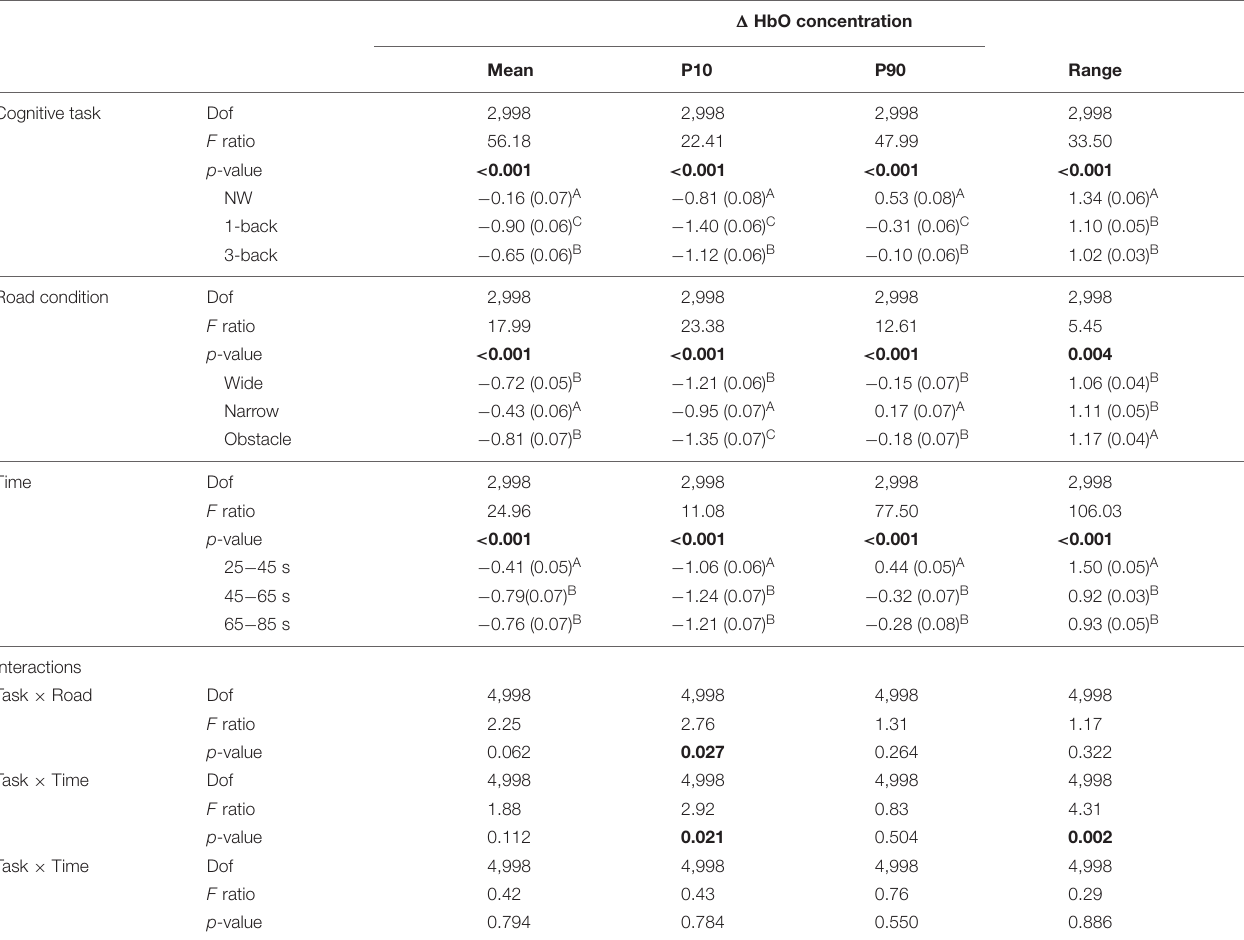
TABLE 3 | Summary of changes in oxygenated hemoglobin concentration in the prefrontal pole area for rANOVA main effects and p -values for the interactions 1 , 2 . (cid:49) HbO concentration Mean P10 P90